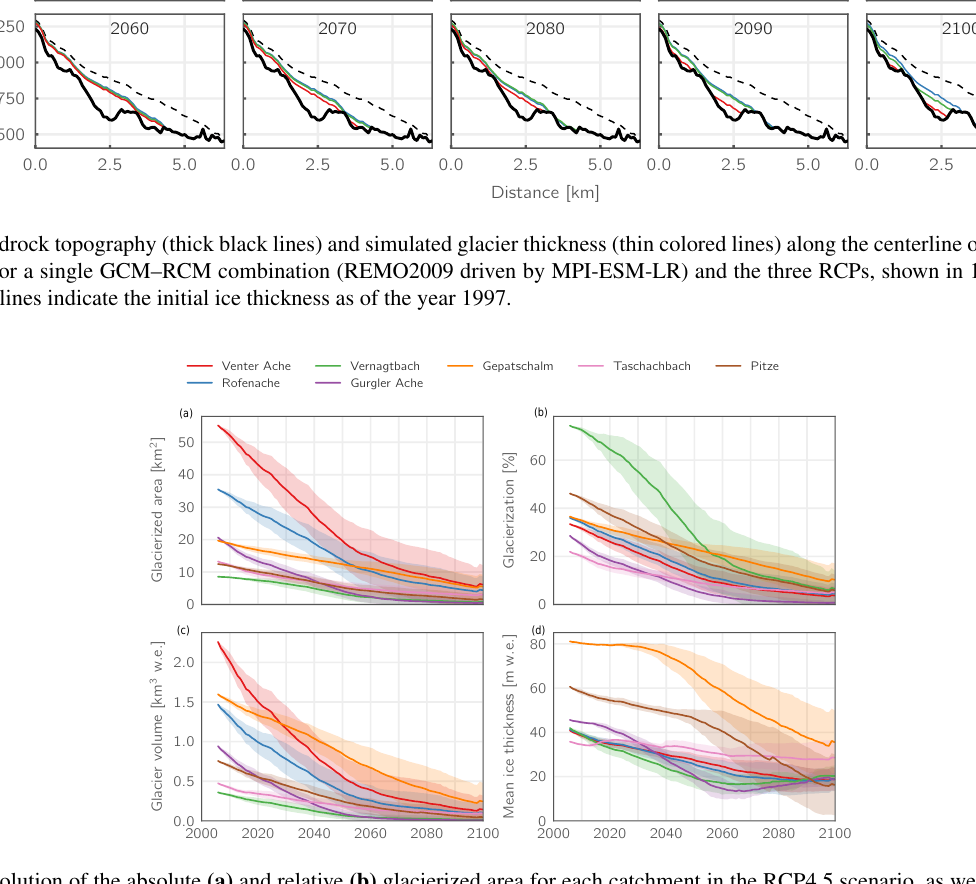
Figure 13. Evolution of the absolute (a) and relative (b) glacierized area for each catchment in the RCP4.5 scenario, as well as the absolute glacier volume (c) and the mean ice thickness (d) . Note that the latter is calculated only over the glacierized fraction of the catchment and not the entire catchment area (i.e., it is the result of dividing c by a ). Lines and shadings represent multi-model means ±